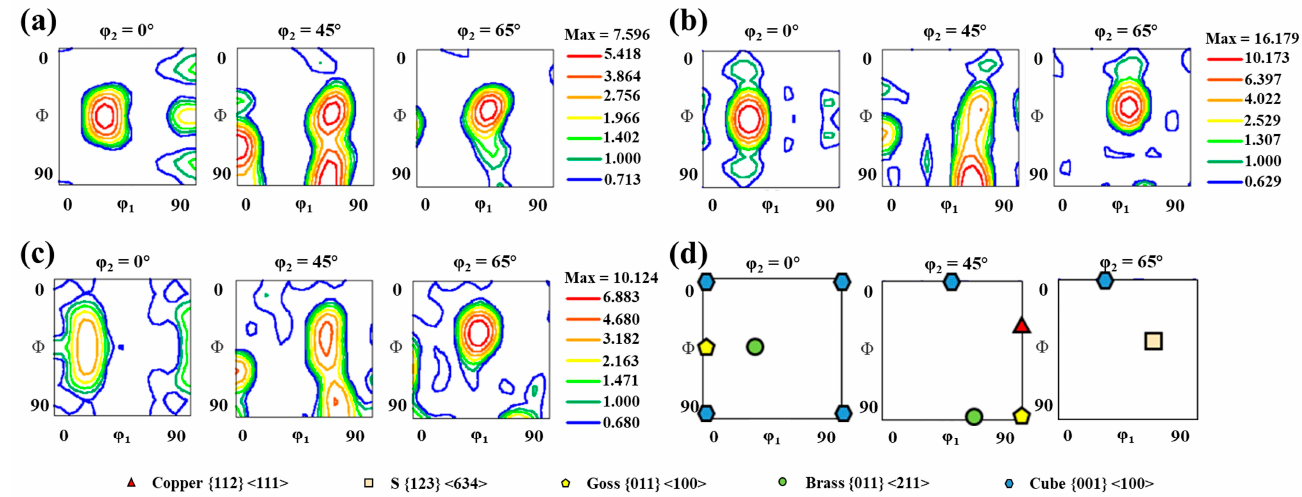
Figure 8. Orientation distribution function for φ 2 = 0°, 45° and 65° in ( a ) M1, ( b ) M2, ( c ) M3 after three MARB cycles, and ( d ) ideal positions for typical texture of FCC crystals.